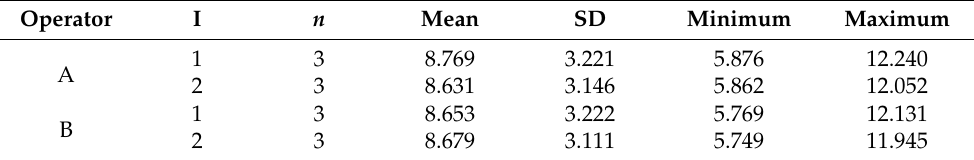
Table 1. Descriptive statistics of the area of the cement remaining after lingual multibracket therapy debonding, the area of the cement remaining after cement clearance, and the area of the enamel removed after cement